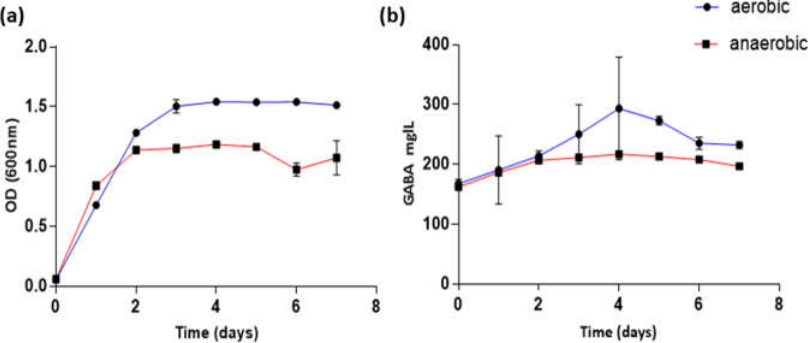
Figure 2. ( a ) Growth curve and ( b ) GABA production of THSK under aerobic and anaerobic condi- tions.